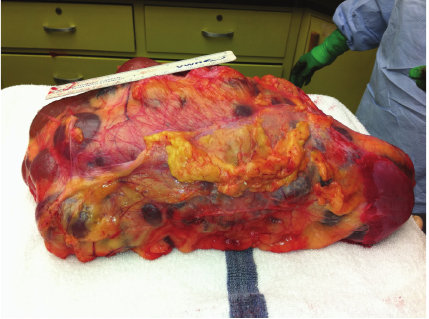
Figure 1: Macroscopic image of right kidney, 2400 grams.